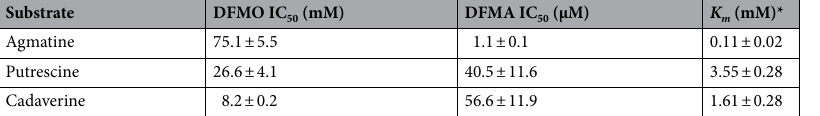
Table 2. DFMO and DFMA IC 50 with the Michaelis–Menten constant ( K m ) of the enzyme for different decarboxylase substrates. *Previously reported 18 .